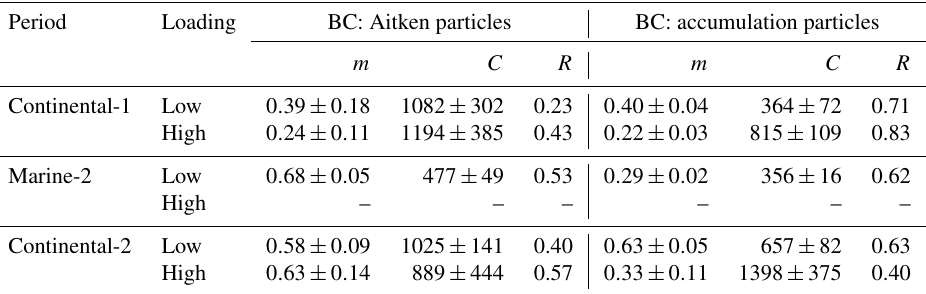
Figure 12. Association between CCN (at 0.3% SS) and absorption coefficient (at 550nm) for (a) continental-1 (b) continental-2, (c) marine- 1, and (d) marine-2 conditions. The color of the scatter indicates the concurrent absorption Ångström exponent values. The least-square linear fit is also shown along with the fit parameters. Table 3. The linear fit parameters between BC mass and Aitken/accumulation mode particle concentration under different loading and air mass